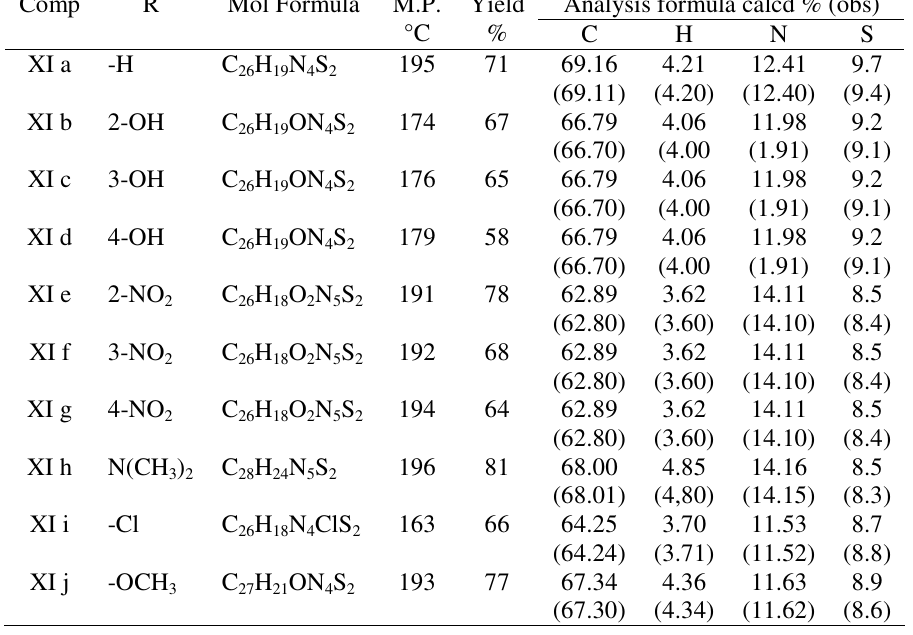
Table 2. Characterization data of newly synthesized compounds (XI a-j)